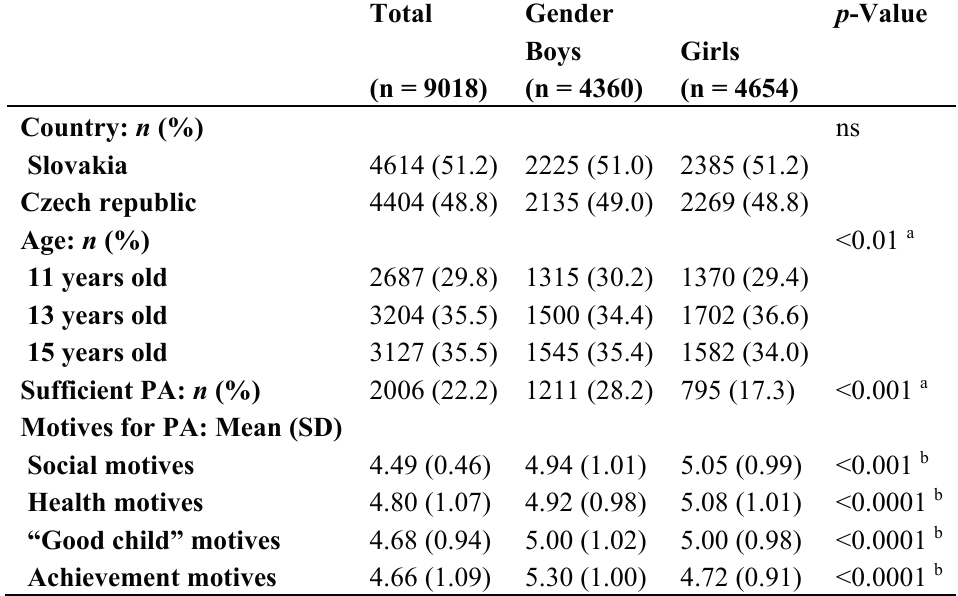
Table 1. Descriptive statistics for country, age, sufficient PA and motives for PA for the whole sample and separately for boys and